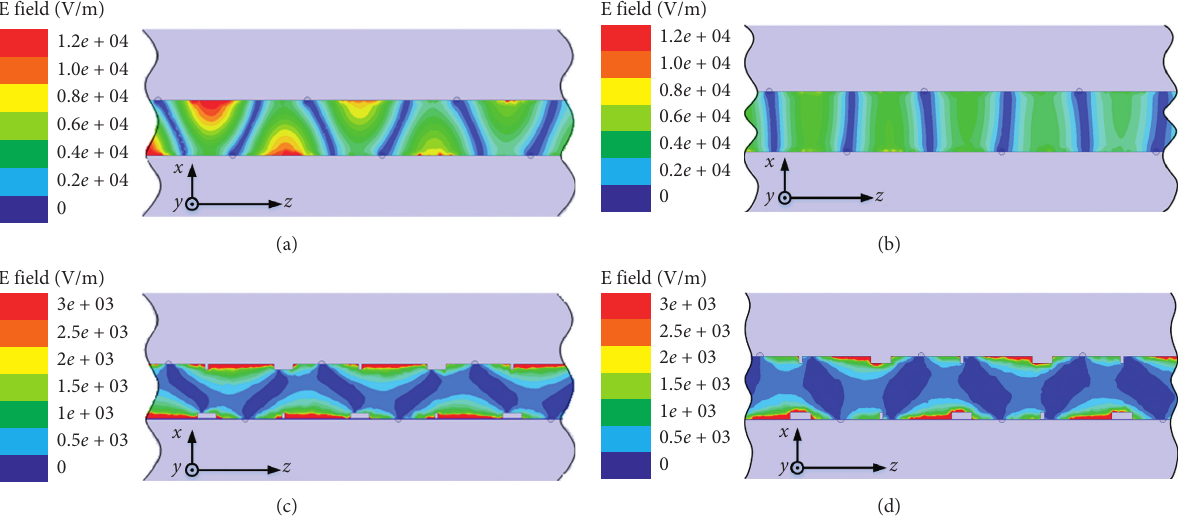
Figure 12: Electric field distribution of the proposed antenna at OSB frequency. (a) Without slots, phase � 0 degree. (b) Without slots, phase � 90 degree. (c) With slots, phase � 0 degree. (d) With slots, phase � 90